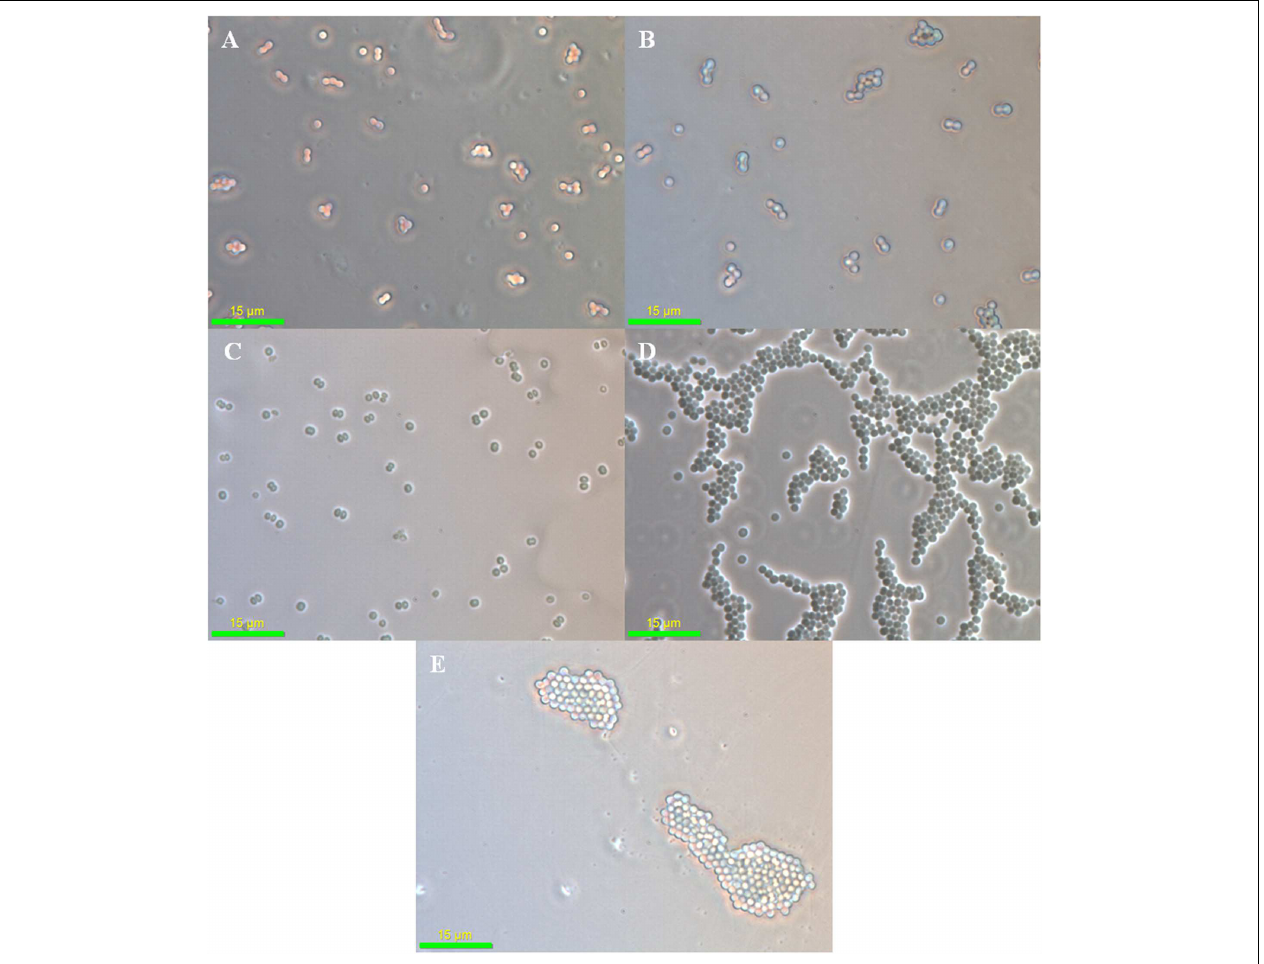
FIGURE 2 | Phase contrast microscopy analysis of arsenic treated Synechocystis cells. No significant difference was observed in control (A) , 75 mM As (V) (B) , and 300 mM As (V) (C) treated cells. Strong aggregation of cells was observed at 1 mM (D) and 4 mM (E) As (III)